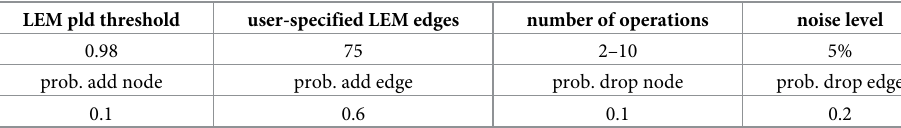
Table 7. Network finding hyperparameters for yeast cell cycle. LEM pld